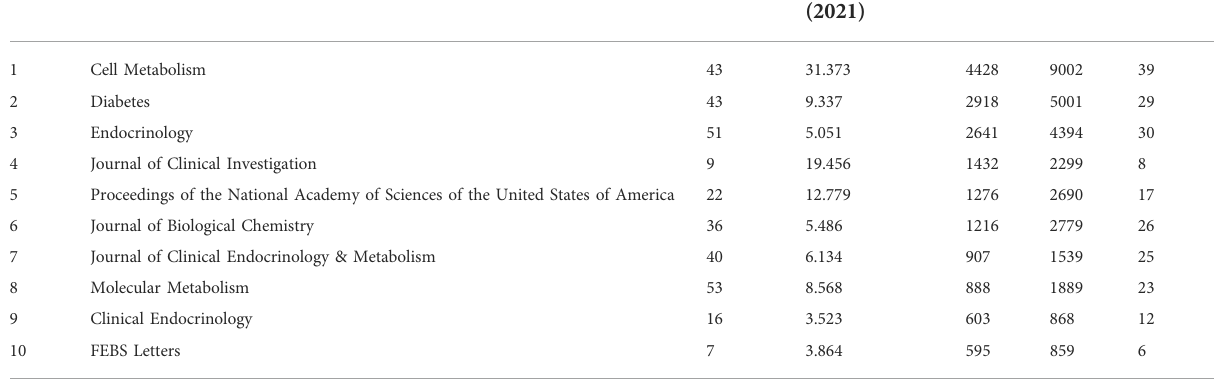
TABLE 4 Top ten journals with the highest